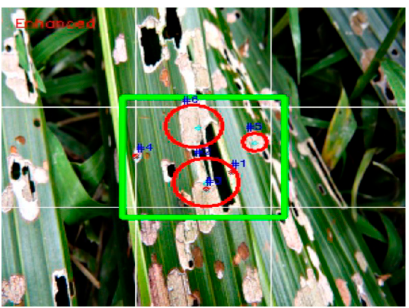
Figure 11. Wrong detection of targeted objects through the color processing technique.